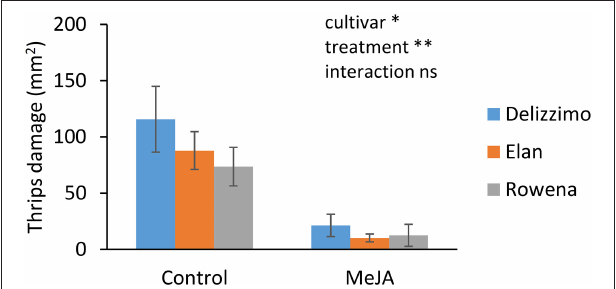
FIGURE 3 | Effect of MeJA treatment on plant resilience at the end of a strawberry nursery measured by a thrips ( Frankliniella occidentalis ) detached leaf bioassay. Damage was visually estimated in mm 2 . Data present mean ± SEM ( n = 10). Significant differences are indicated as * p ≤ 0.01, ** p ≤ 0.001, based on GLM using a Wald chi-squared